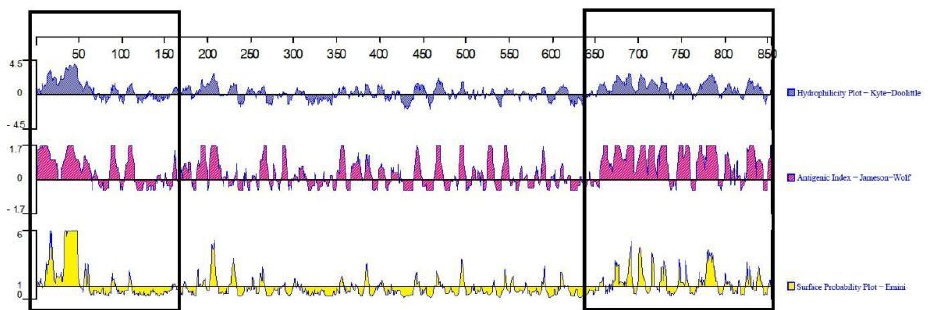
Figure 3. Analysis of physical and chemical properties of Cap protein. The hydrophilicity plot is shown in blue, the antigenic index is shown in red, the surface probability plot is shown in yellow, and the amino acids with a higher probability of deduced protein surfaces are circled in boxes. using the Bepipred 2.0 and SVMTriP online analysis software. The results show that the